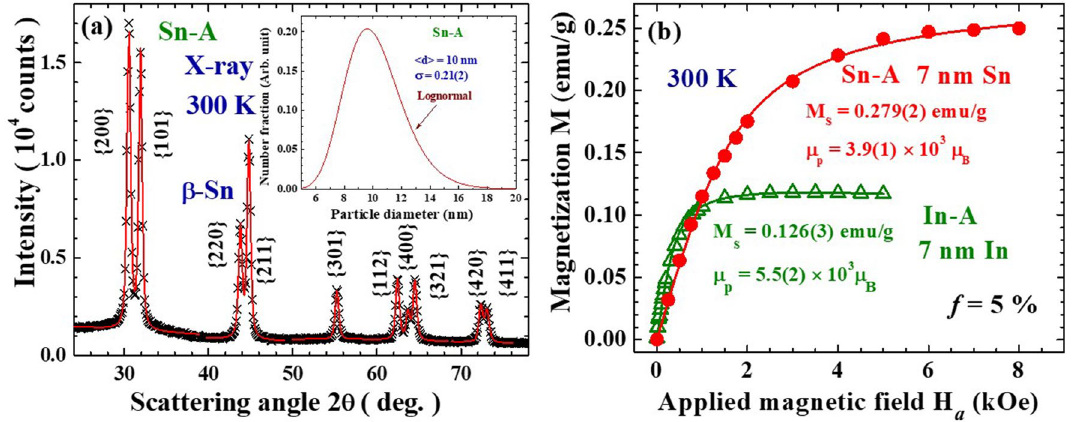
Figure 1. ( a ) X-ray diffraction pattern of the Sn-A nanoparticle assembly, taken at room temperature, revealing a tetragonal β-Sn structure. The solid curves indicate the calculated profile using the size distribution shown in the inset, giving a mean particle diameter of 10 nm for the Sn-A nanoparticles. ( b ) Isothermal magnetization curves of 7 nm In-A (open triangles) and 7 nm Sn-A (filled circles) nanoparticle assemblies at a packing fraction of f = 5%, measured in field-increasing loops at 300 K. The solid curves indicate the fits of the data to the Langevin profile, giving saturation magnetizations of 0.126(3) and 0.279(2) emu/g for the 7 nm In-A and 7 nm Sn-A nanoparticles,